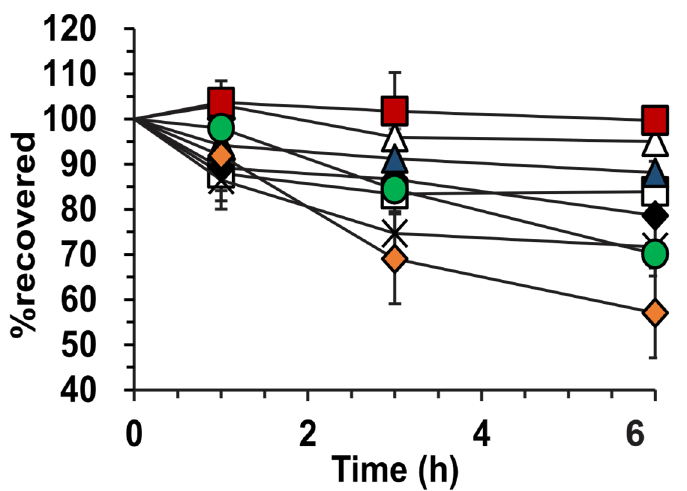
Figure 3. Photostability of griseofulvin-containing formulations. ( ∆ ) Hyaluronic-stabilized emulsion, ( □ ) amylopectin-stabilized emulsion, ( ♦ ) alginic acid-stabilized emulsion, ( ) hyaluronic-